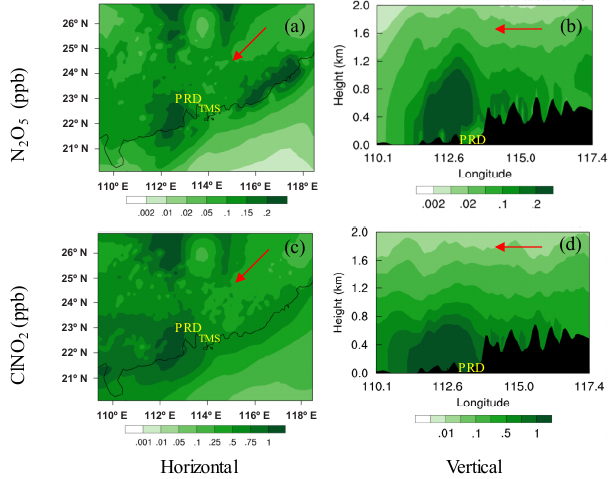
H o r i z on t a l V e r ti ca l Figure 3. Horizontal distributions of (a) N 2 O 5 and (c) ClNO 2 average mixing ratios (ppb) during night-time (18:00–07:00LT) within the PBL from the HET + Cl case; vertical distributions of (b) N 2 O 5 and (d) ClNO 2 average mixing ratios (ppb) during night- time (18:00–07:00LT) in the domain intercepting PRD and along the prevailing wind direction from the HET + Cl case. Red arrows represent the prevailing wind direction. The black shading in verti- cal plots represents terrain